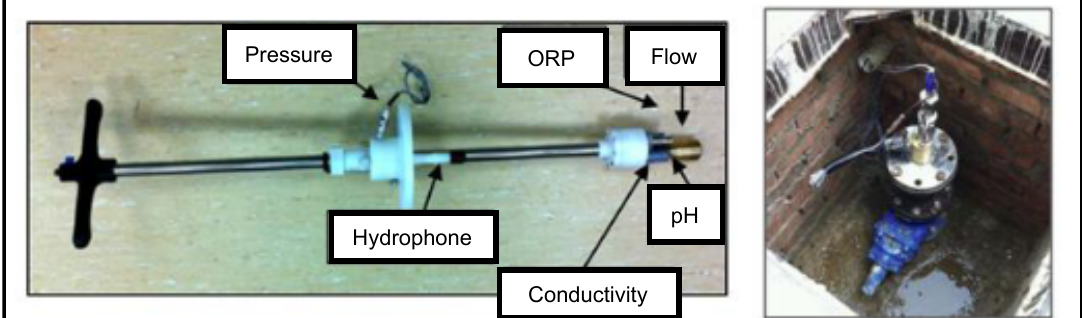
Figure 3. Water-Wise Sensors used in the Singapore city